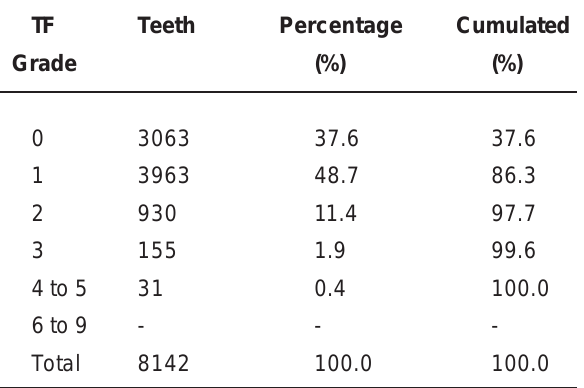
TABLE 2 - Number of Teeth by TF grades in children attending basic health units in Londrina,